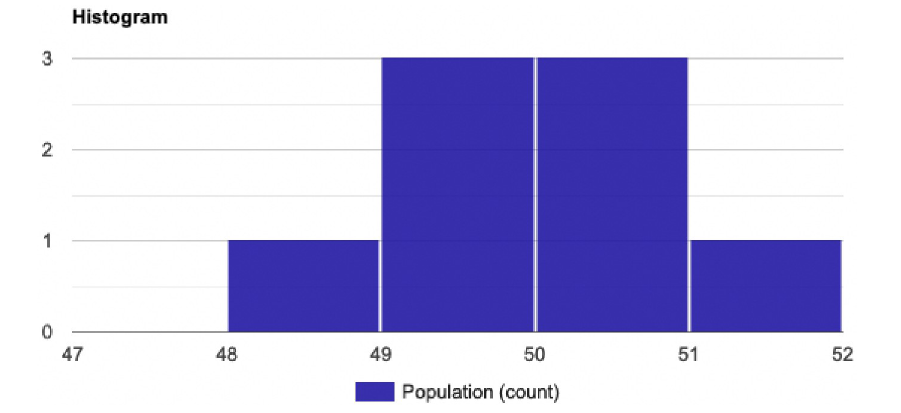
Fig 16. The probability density function for cost function g(X).